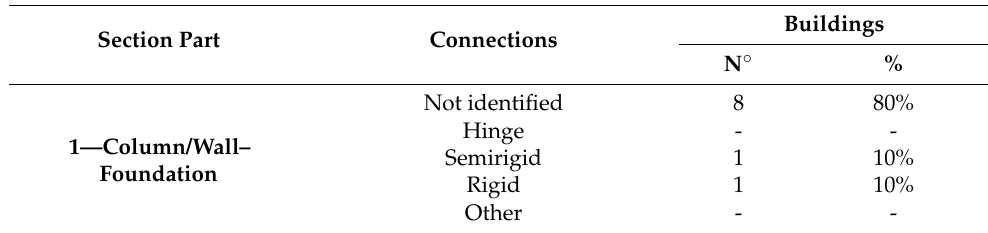
Table 12. Section 2C CARTIS-Building. Case studies characterization: Typology of connections, panels, special loads, and other non-structural elements—Synoptic panel. Section 2C: Typology of Connections, Panels, Special Loads, and Other